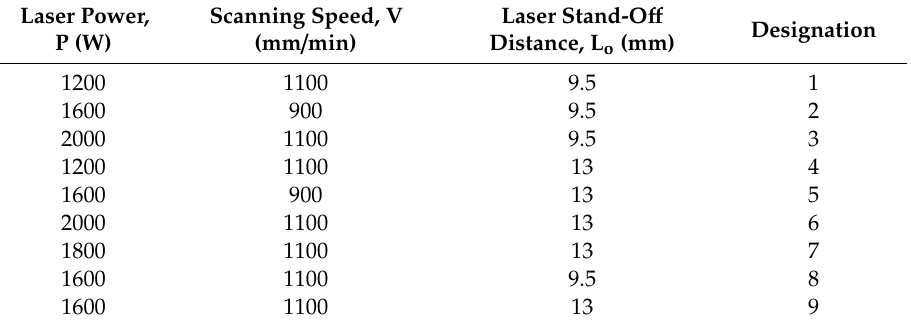
Table 2. Parameter sets used in the designed experiments.